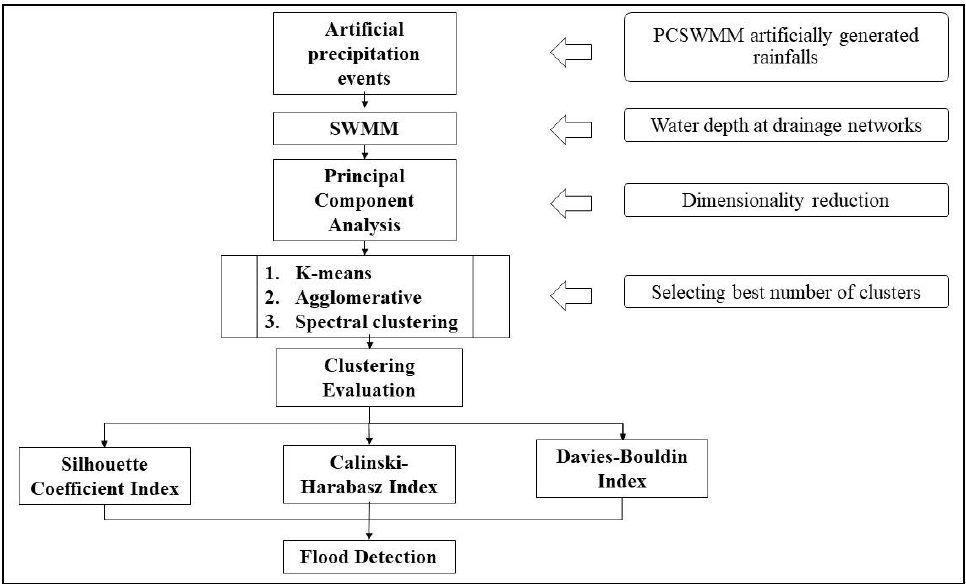
Figure 1. Representing the workflow of the whole study.